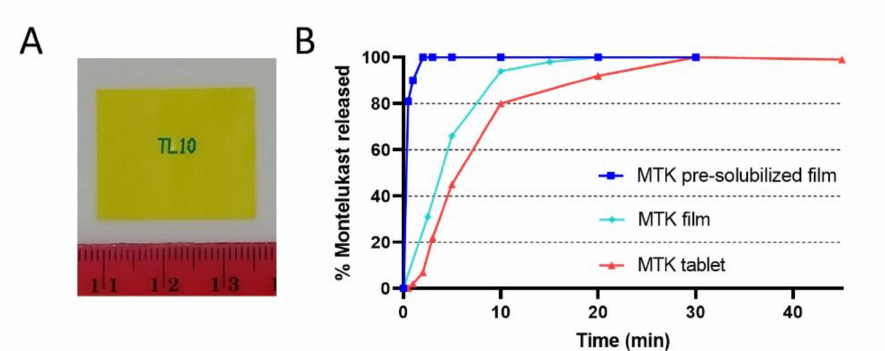
Figure 1. Characterization of the Montelukast oral film. ( A ) Image of a Montelukast (MTK) oral film from IntelGenx (scale in (cm)). ( B ) Graphical representation comparing the in vitro dissolution rates of (Turquoise) the MTK oral film, (Blue) pre-solubilized MTK oral film, and (Red) MTK tablet Singulair ® . Eighty percent MTK release is reached after approximately 1 min with the pre-solubilized film, after approximately 6 min with the oral film and after 10 min with the